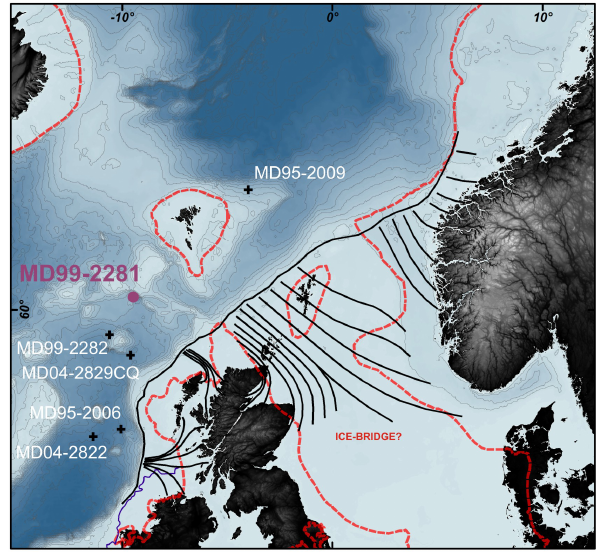
Fig. 8. BIIS-FIS ice sheets and their associated paleo-ice-stream main directions (black solid line, Bradwell et al., 2008). The full glacial extension of the North Hemispheric ice sheets is schema- tized by the red dotted-line (Grosswald and Hughes, 2002); Ehlers and Gibbard, 2004). Palaeo-coastline at 21kaBP in blue (Bourillet et al., 2003). The studied core (MD99-2281: this work) and other cores discussed in the paper (MD95-2009; Eynaud et al., 2002; MD04-2822; MD95-2006; Knutz et al., 2001; Hibbert et al., 2010; MD04-2829CQ; Hall et al., 2011) are also